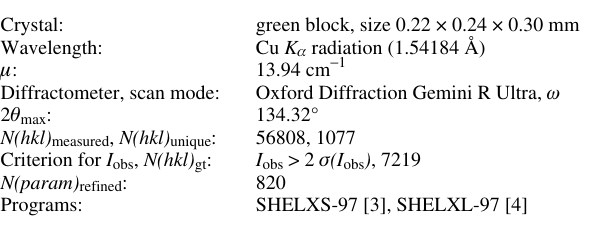
Table 1. Data collection and